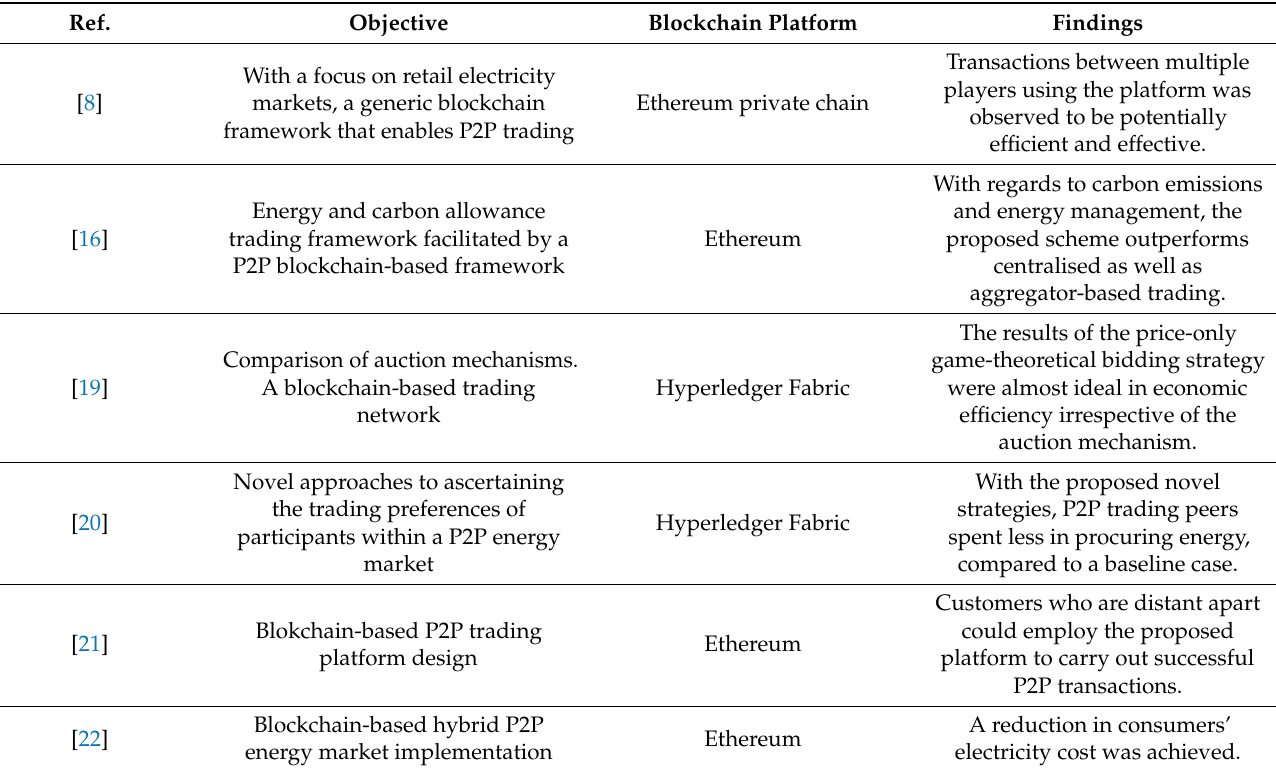
Table 1. Objective, blockchain platform, and findings of selected articles.